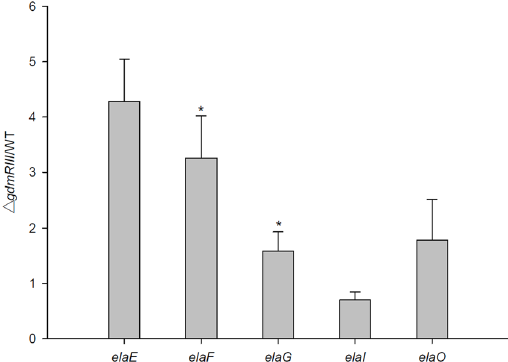
Figure 4. Analyses of the transcriptional levels of genes in the elaiophylin biosynthetic gene cluster. Values are the average of three independent experiments, each with three replicates. Error bars indicate the standard deviation of means. * p < 0.05, ** p < 0.01 by paired samples